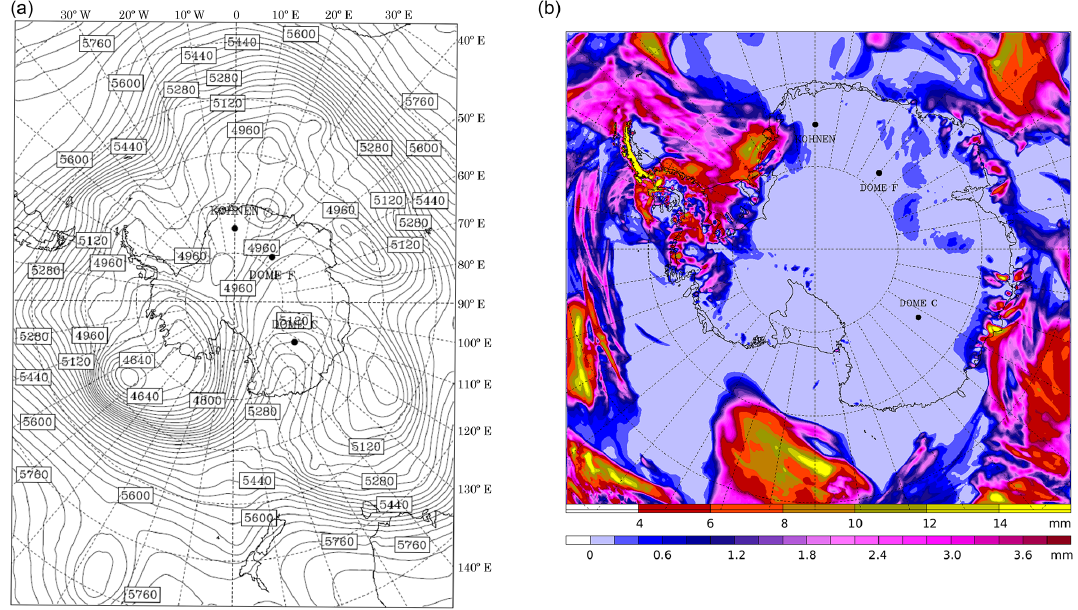
Figure 6. Example for synoptic situation, during which precipitation is observed at Dome C, but not forecast by WRF in AMPS. (a) 500hPa geopotential height, Domain 2. (b) 24h precipitation total (mm) from